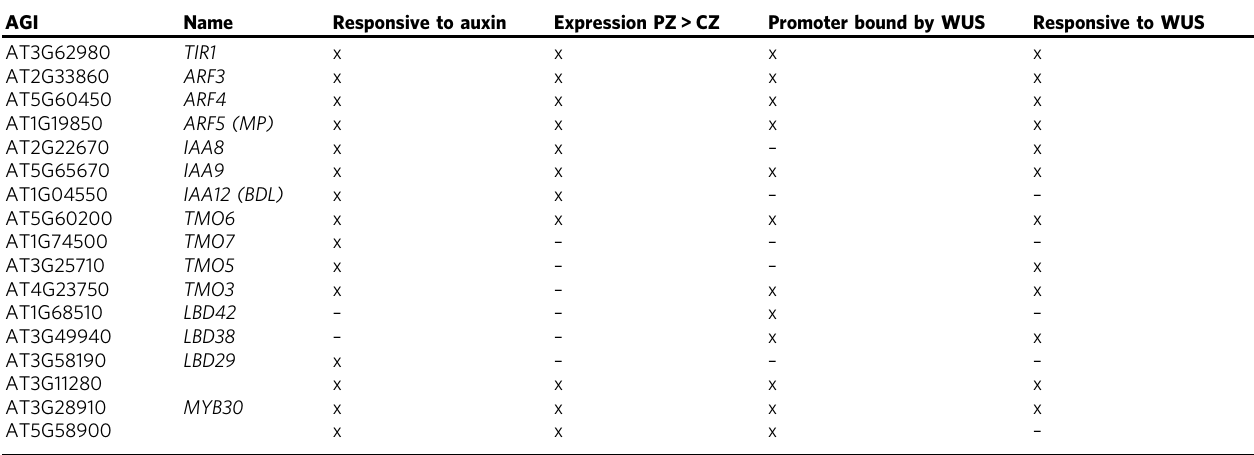
Table 1 WUS targets functionally tested by stem cell speci fi c expression